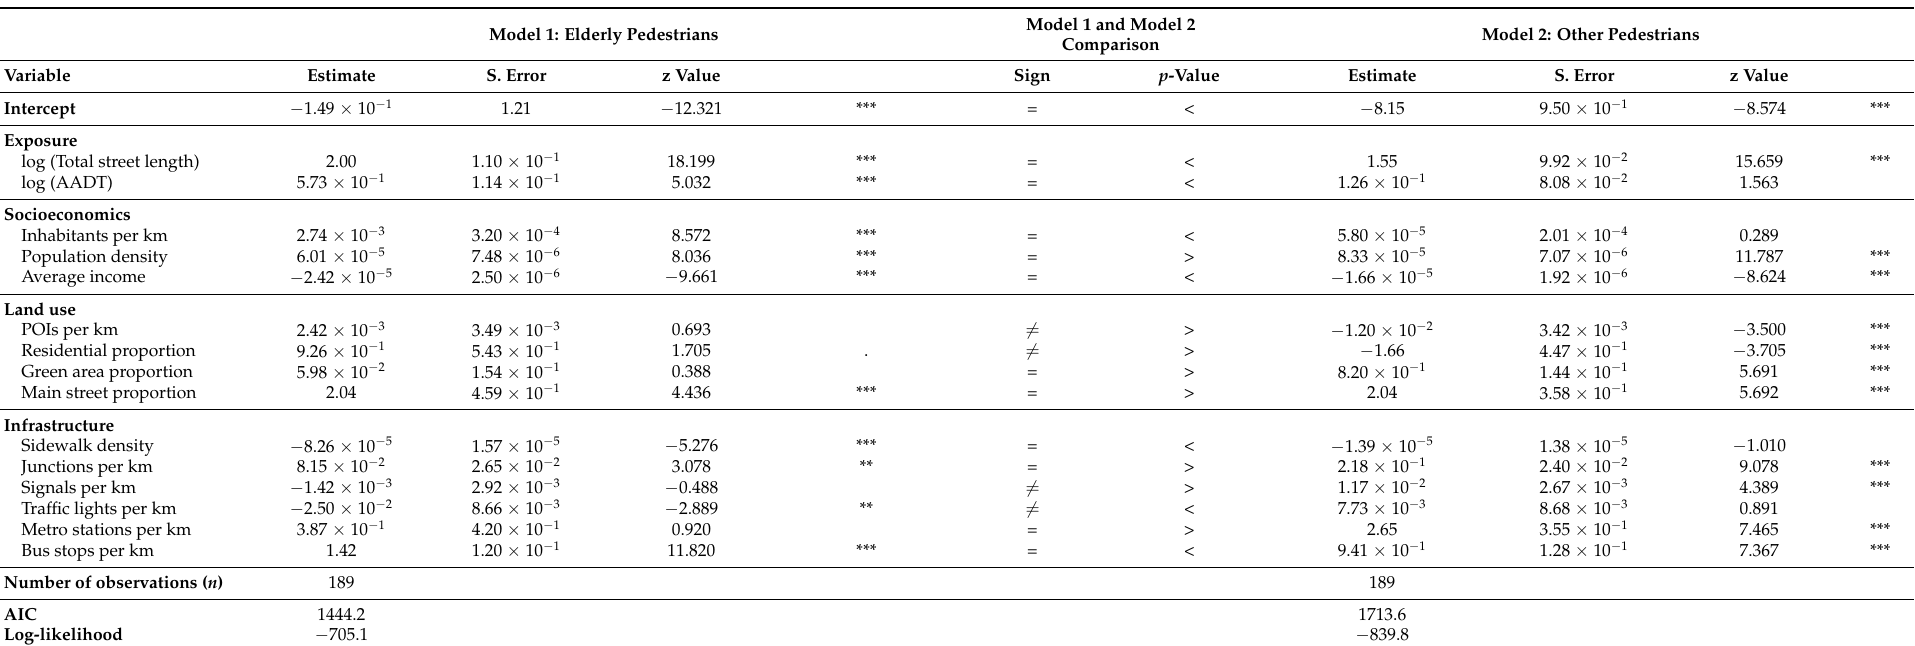
Table 2. Results of the Negative Binomial (NB) regression models. Model 1: Elderly Pedestrians Model 1 and Model 2 Comparison Model 2: Other